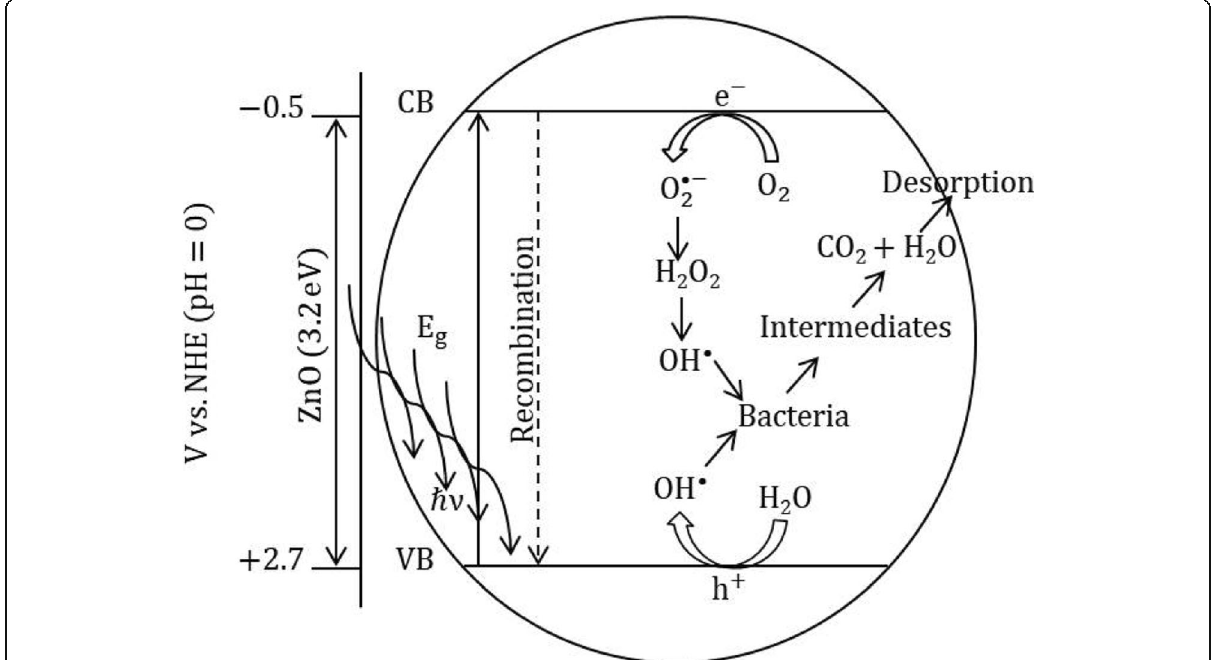
Fig. 1 Schematic illustration of the ZnO photocatalytic bacterial degradation mechanism